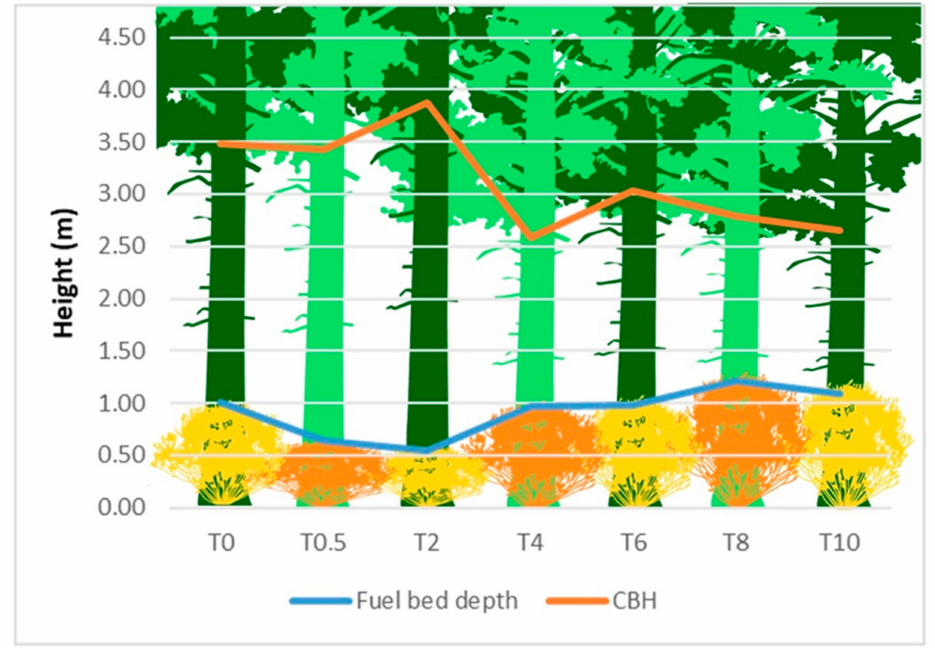
Figure 4. Evolution of the vertical fuel gap between surface and canopy fuels, which can be considered one of the main factors defining the possibility of fire